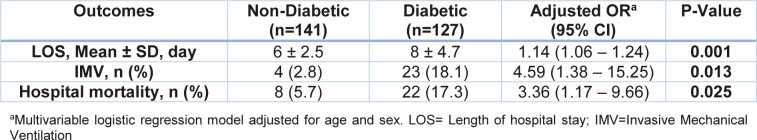
Multivariable analyses, patients with diabetes vs. patients without diabetes